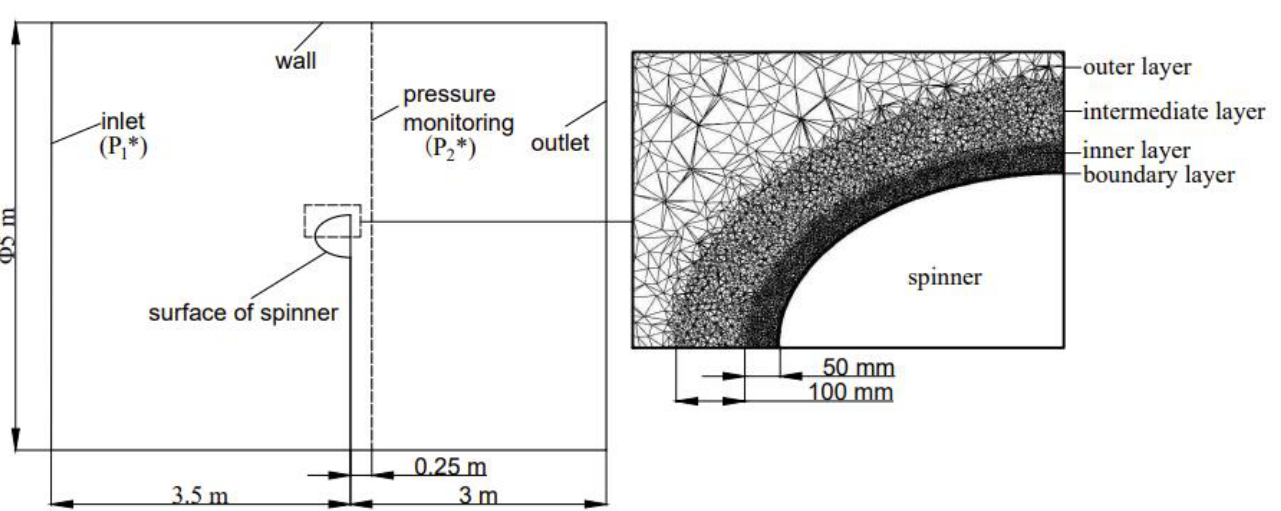
Table 1. Model and working condition.